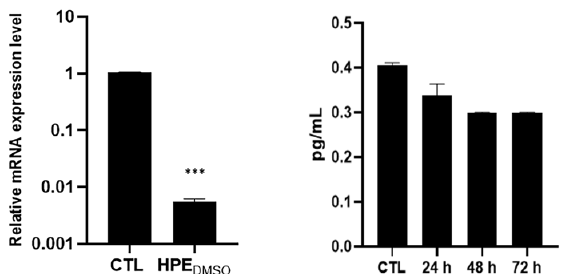
Figure 6. Effects of HPE DMSO on MMP-13 production. Cells were treated with 0.1 mg/mL HPE DMSO for 24 h and then the mRNA was extracted and analyzed by RT-PCR. MMP-13 mRNA level was reported as relative mRNA expression level with respect to 18S mRNA (2 − ∆∆ Ct method). The amount of MMP-13 produced was measured in the culture medium of cells and analyzed by ELISA. The results are reported as pg/mL. Results are expressed as mean ± SEM of data obtained by three independent experiments. *** p < 0.005 vs. CTL.